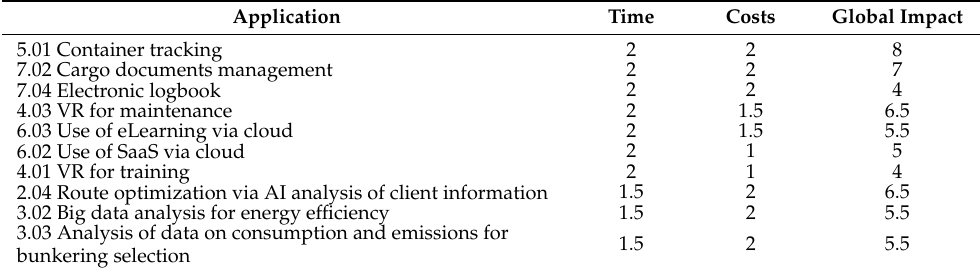
Table 14. Quick-win